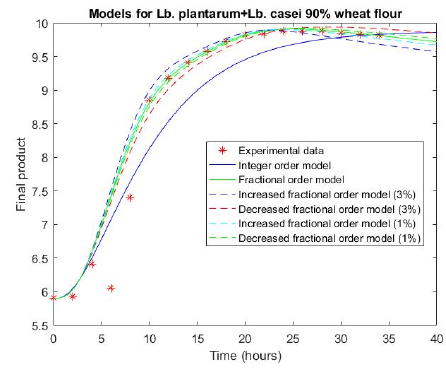
Figure 9. Comparison between simulated and experimental data for experiment 3 using both types of bacteria. Table 1. Mean square errors for each experiment.